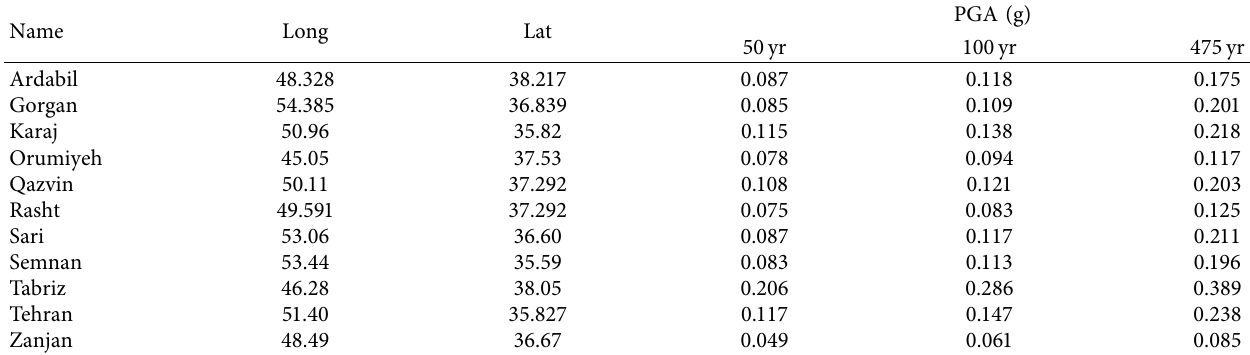
Figure 7: Map of 90% quintile of distribution of maximum values of log ( A � 475 max ) on the future time interval of the length T Table 1: Estimated earthquake values in some cities of the Alborz-Azerbaijan province.